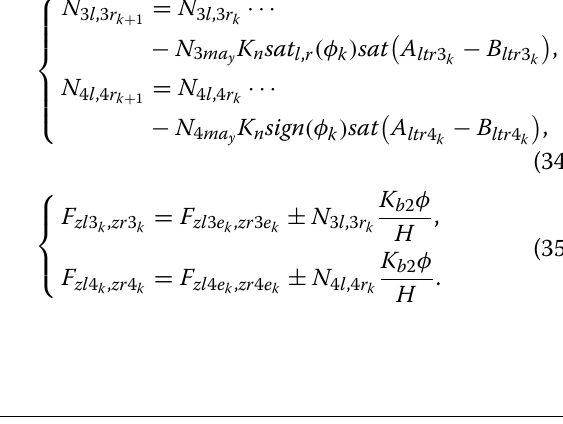
adjustment to the calculations of A ltr 3, ltr 4 and B ltr 3, ltr 4 in the next step. The values of F zr 3 e k , zl 3 e k and F zr 4 e k , zl 4 e k are directly calculated using the vertical force model.